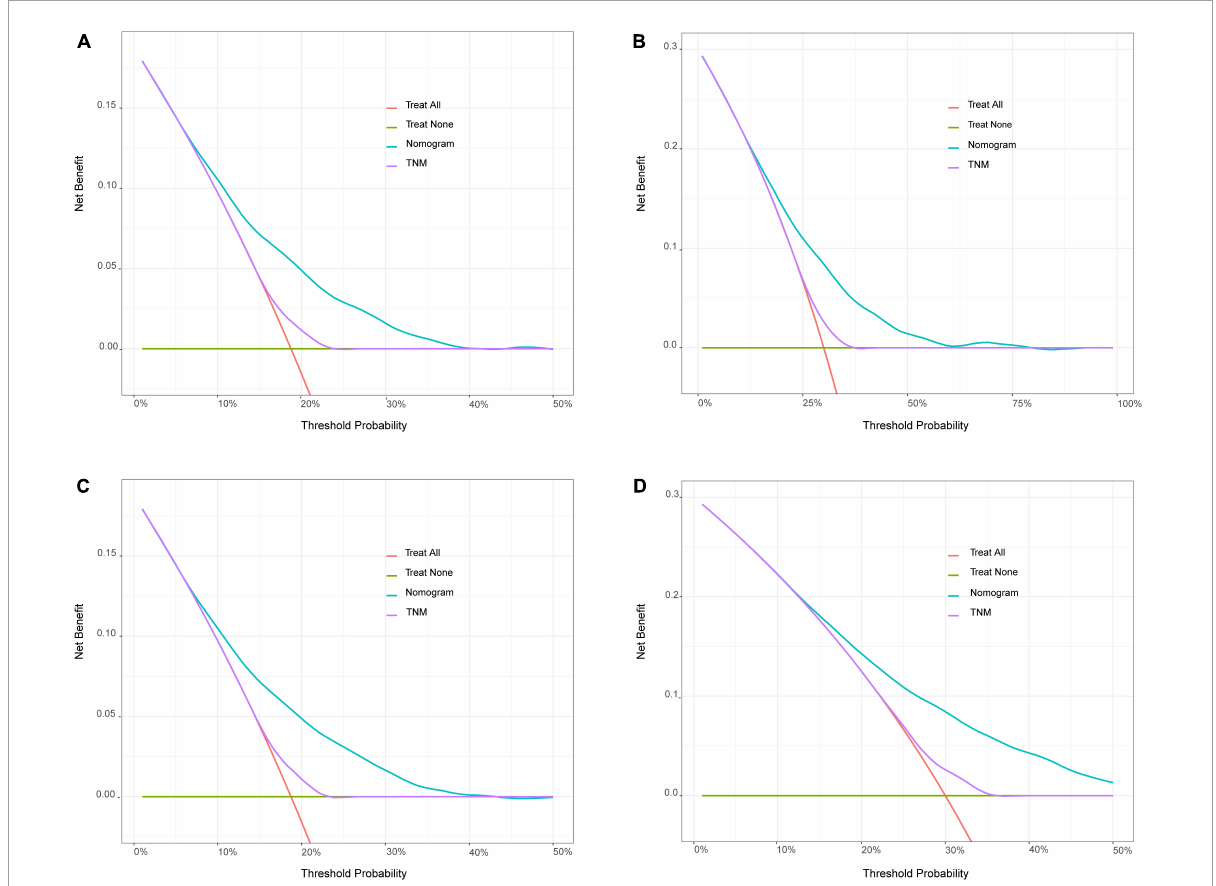
FIGURE4 Decision curve analysis (DCA) for the nomogram model and the 8th edition AJCC TNM staging system. (A) Comparison of 3 years of DCA in training set. (B) Comparison of 5 years of DCA in training set. (C) Comparison of 3 years of DCA in test set. (D) Comparison of 5 years of DCA in test set. The X-axis referred to the threshold probabilities, defined as the minimum probability of disease at which further intervention would be warranted. The Y-axis referred to the net benefit. When the death rate exceeded a certain value, the clinician should start treatment (intervention) for patients. After starting the treatment, the patients who actually will die would be benefited from the treatment (positive predictivity), and those who will not die would be harmed by the treatment (false positive rate). The net benefit = positive predictivity–false positive rate. The green horizontal line represents none of the patients received intervention and the other oblique orange lines represent all patients have been treated.